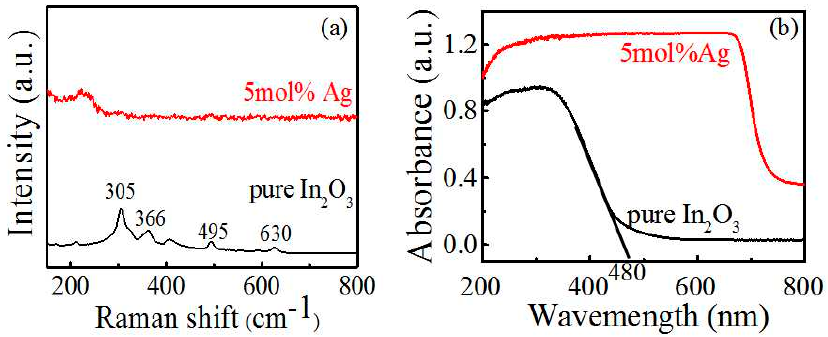
Figure 4. ( a ) Raman spectra and ( b ) UV-Vis spectra of pure and 5 mol % Ag-modified In 2 O 3 nanomaterials.